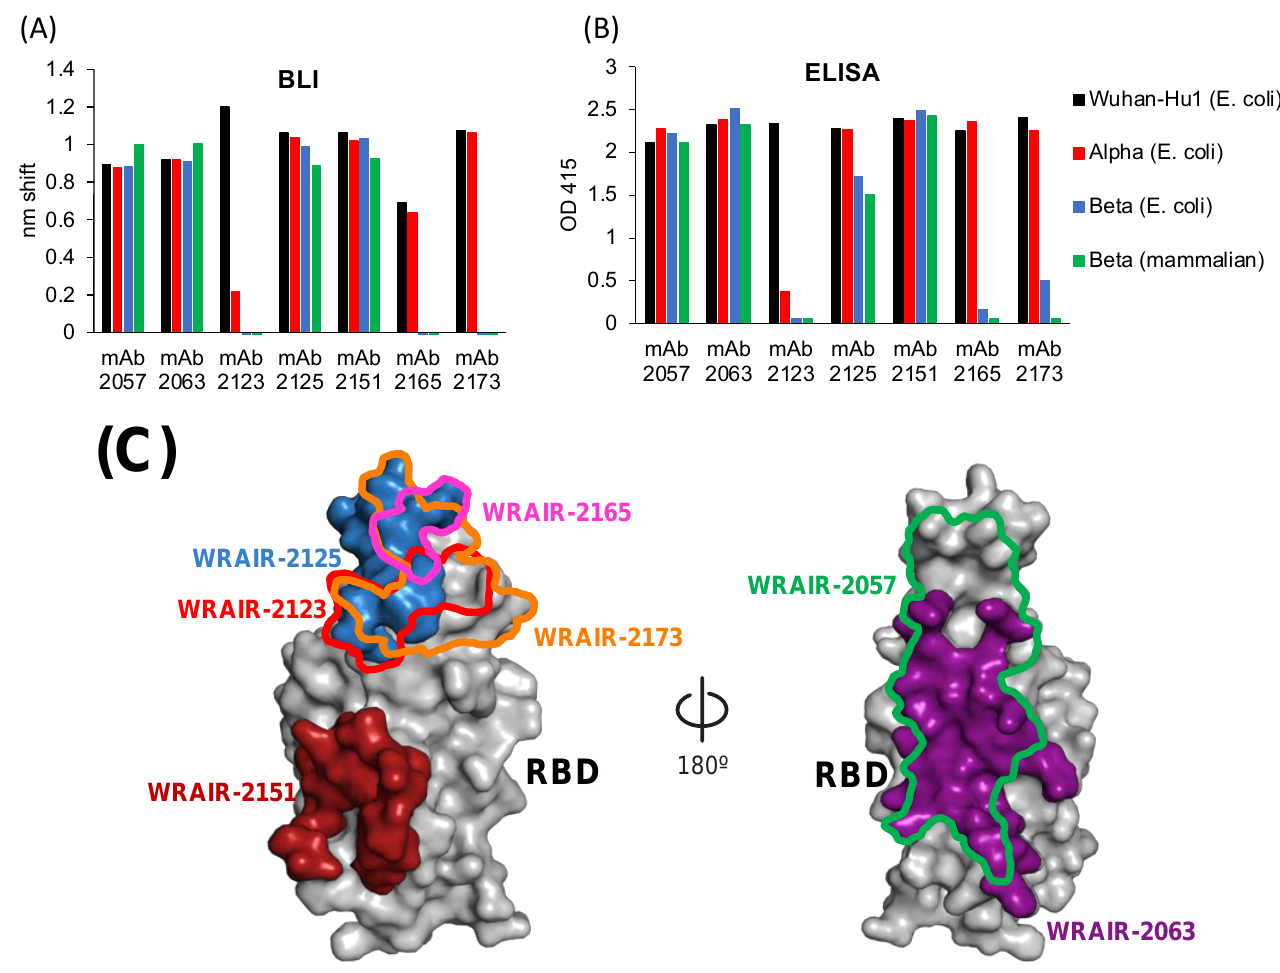
Figure 3. Antigenicity of recombinant RBDs. Novel human mAbs produced against Wuhan-Hu1 (mAbs WRAIR-2057, -2063, -2123, -2125, -2151, -2165 and -2173) were tested for reactivity to recom- binant Wuhan-Hu1, Alpha, and Beta variant RBDs from E. coli and the Beta variant RBD from mam- malian cells using ( A ) BLI and ( B ) ELISA . MAbs WRAIR-2057, -2063, -2125, and -2151 showed broad reactivity, whereas mAbs WRAIR-2123, -2165, and -2173 were variant-specific. ( C ) Epitopes for WRAIR-2151 (PDB: 7N4M), WRAIR-2123, WRAIR-2125 (PDB 7N4L), WRAIR-2165, WRAIR-2173 (PDB: 7N4J), WRAIR-2057 (PDB: 7N4I), and WRAIR-2063 (PDB: 8EOO) are colored red, yellow, blue, pink, orange, green, and purple, respectively.